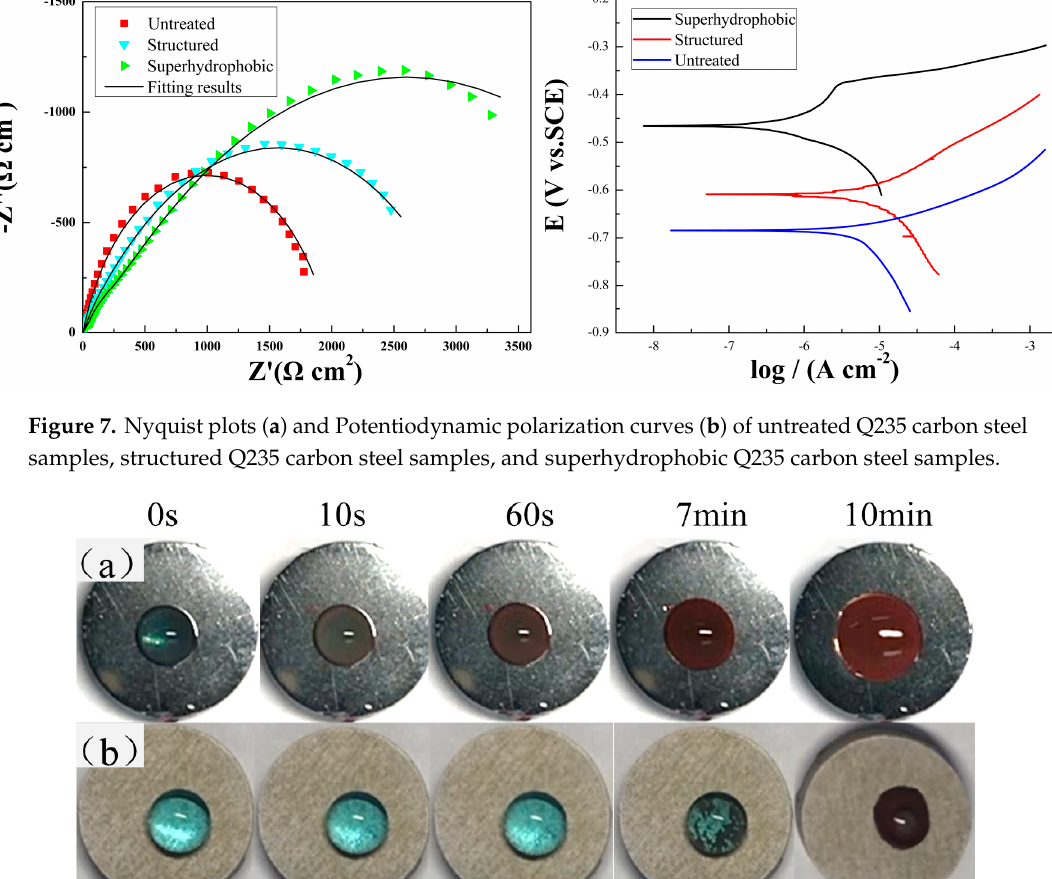
Figure 7. Nyquist plots ( a ) and Potentiodynamic polarization curves ( b ) of untreated Q235 carbon steel samples, structured Q235 carbon steel samples, and superhydrophobic Q235 carbon steel samples.